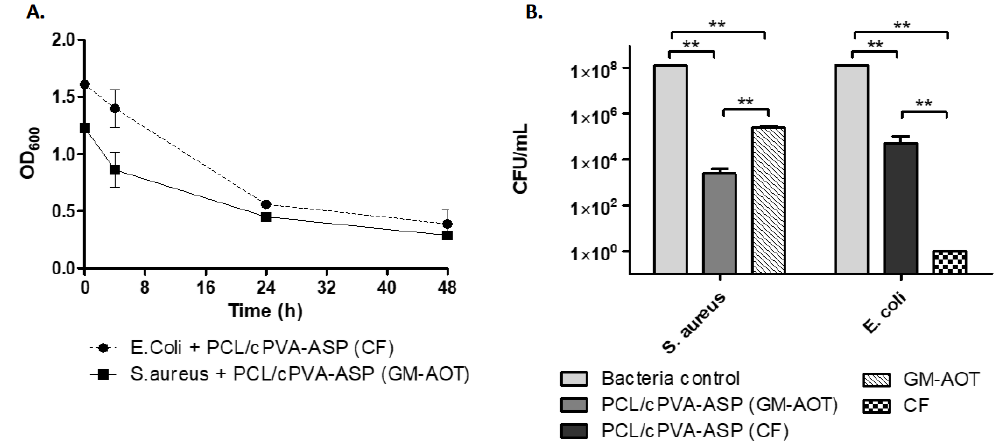
Figure 6. ( A ) Optical density at 600 nm of Escherichia coli and Staphylococcus aureus bacterial dispersions ( n = 3) monitored over 48 h. ( B ) Remaining CFU concentrations of control bacterial dispersions ( n = 3) and bacterial dispersions treated with antibiotic loaded PCL/cPVA-ASP or with free solubilized antibiotics after a 48-h incubation. Error bars indicate SD-values of triplicate values. Student’s t -test ( α = 0.01) with the following legend: ** = p < 0.001.